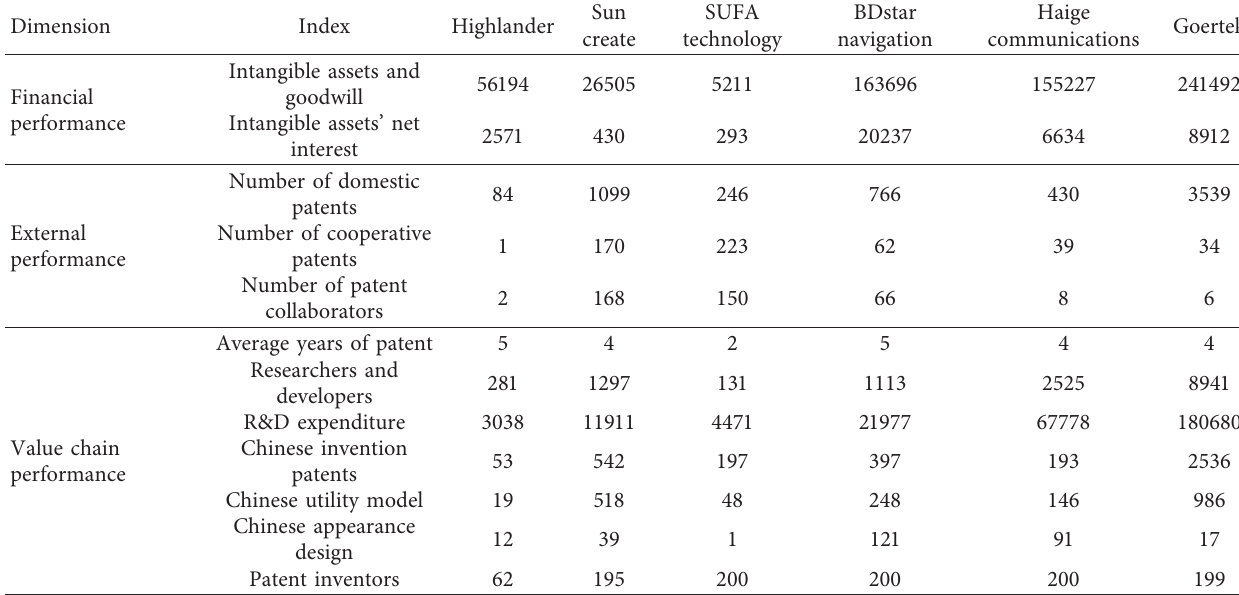
Table 2: Relevant index data of sample enterprises.